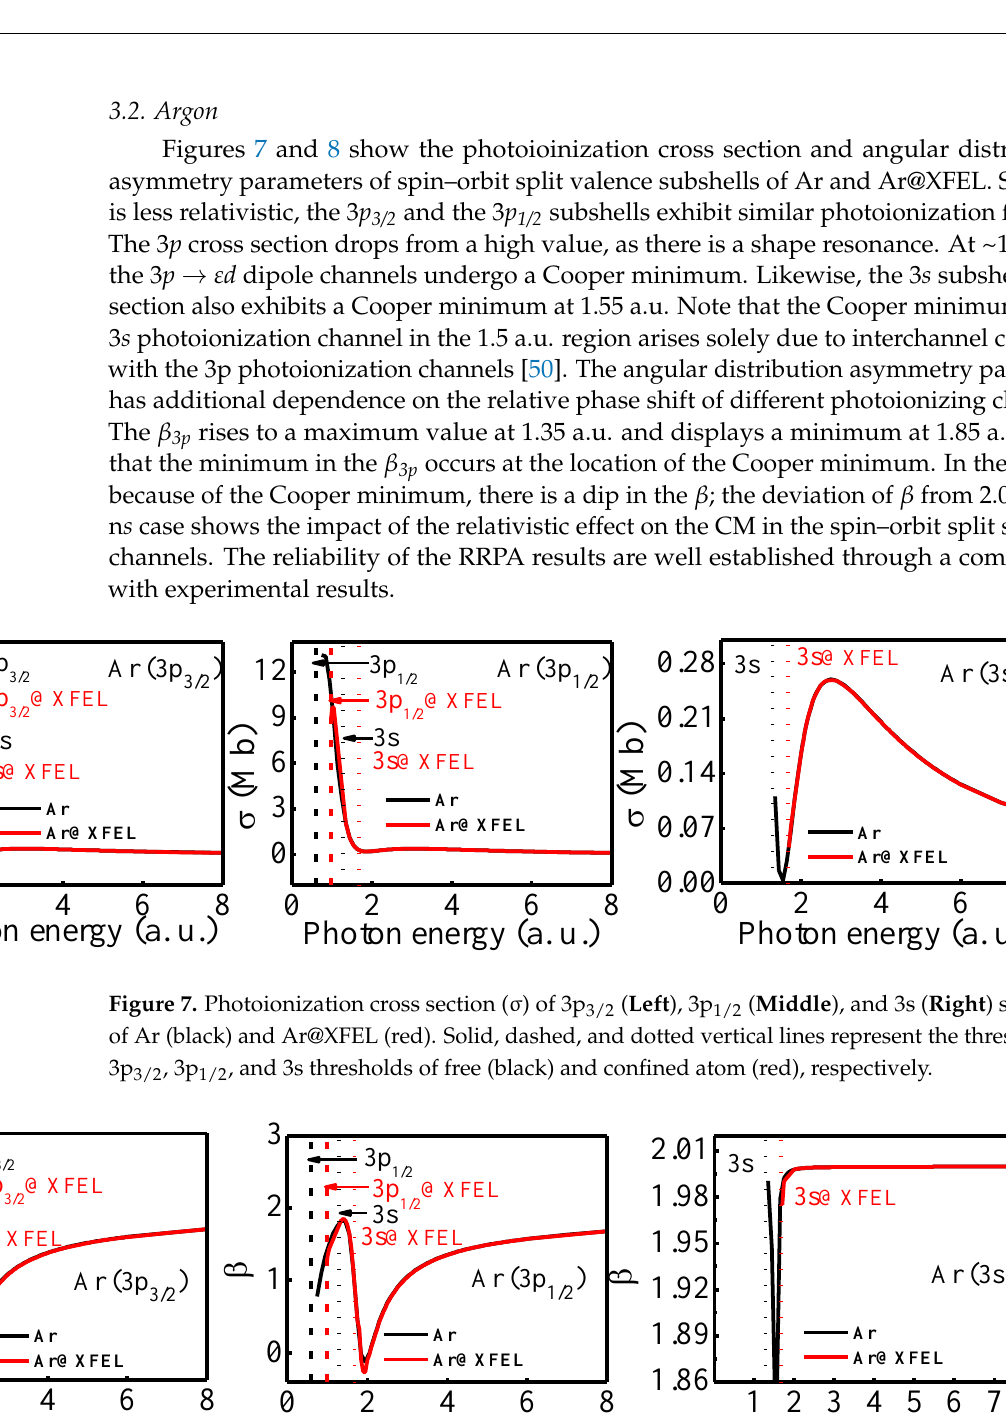
Figure 6. The time delay difference of 2s and 2p subshell (τ(2s)-τ(2p)) of Ne (black) and Ne@XFEL (red) in the RRPA calculation is compared with that from the experiment (blue) [47]. Vertical lines show the 2s subshell threshold for Ne (black) and Ne@XFEl (red).